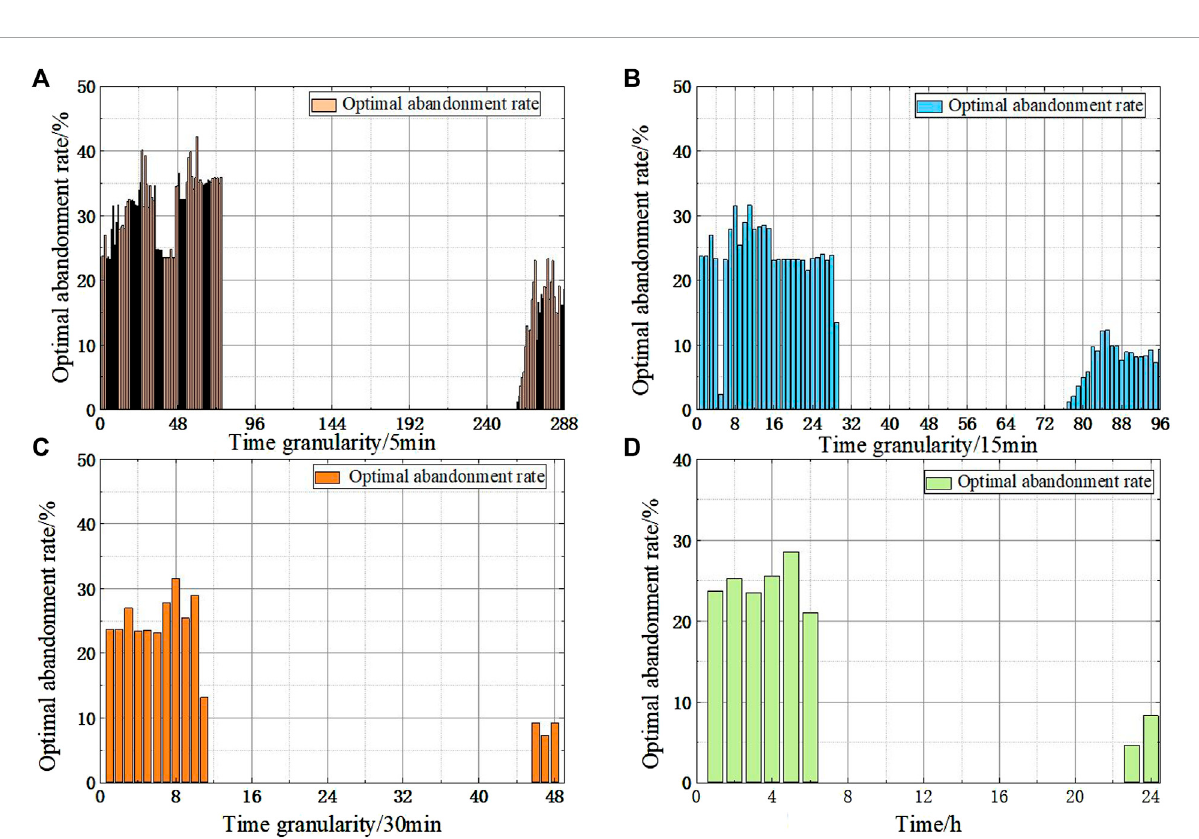
FIGURE 7 Optimal wind curtailment rate at different time granularities. (A) Curtailment rate at 5 min time granularity; (B) Curtailment rate at 15 min time granularity; (C) Curtailment rate at 30 min time granularity; (D) Curtailment rate at 1 h time